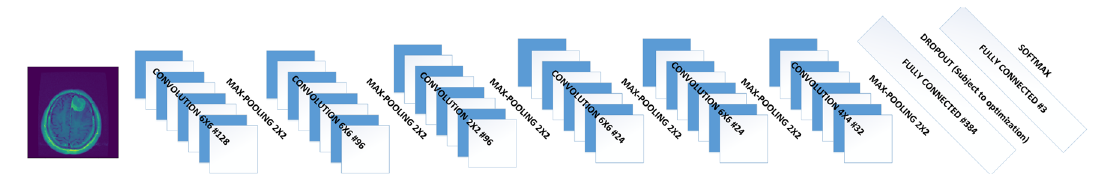
Figure 6. The CNN structure utilized for MRI dataset.